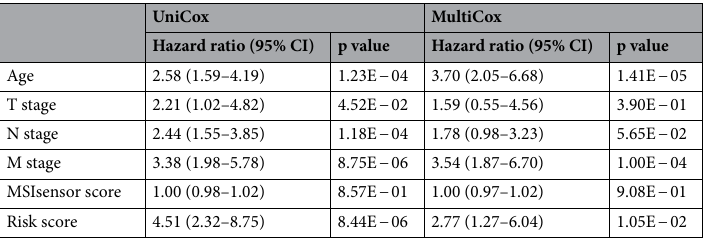
Table 2. Univariate and multivariate Cox regression analysis of overall survival in